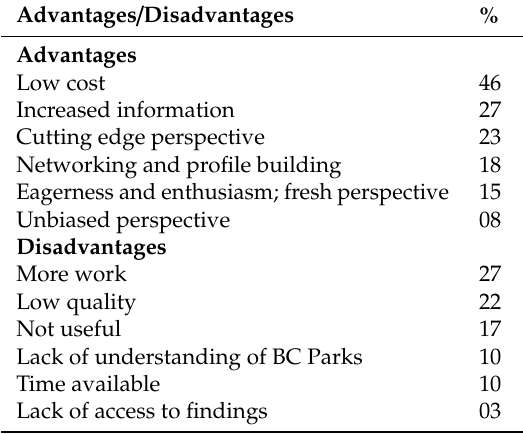
Table 5. Perceived advantages and disadvantages of University- British Columbia (BC) Parks collaborative